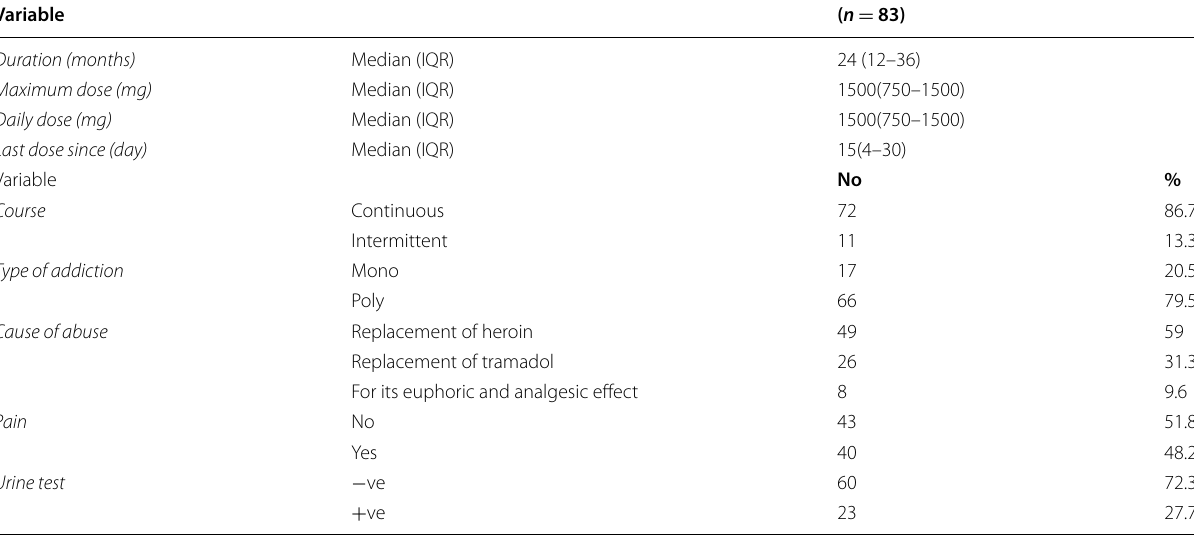
Table 2 Characteristics of pregabalin abuse among the studied